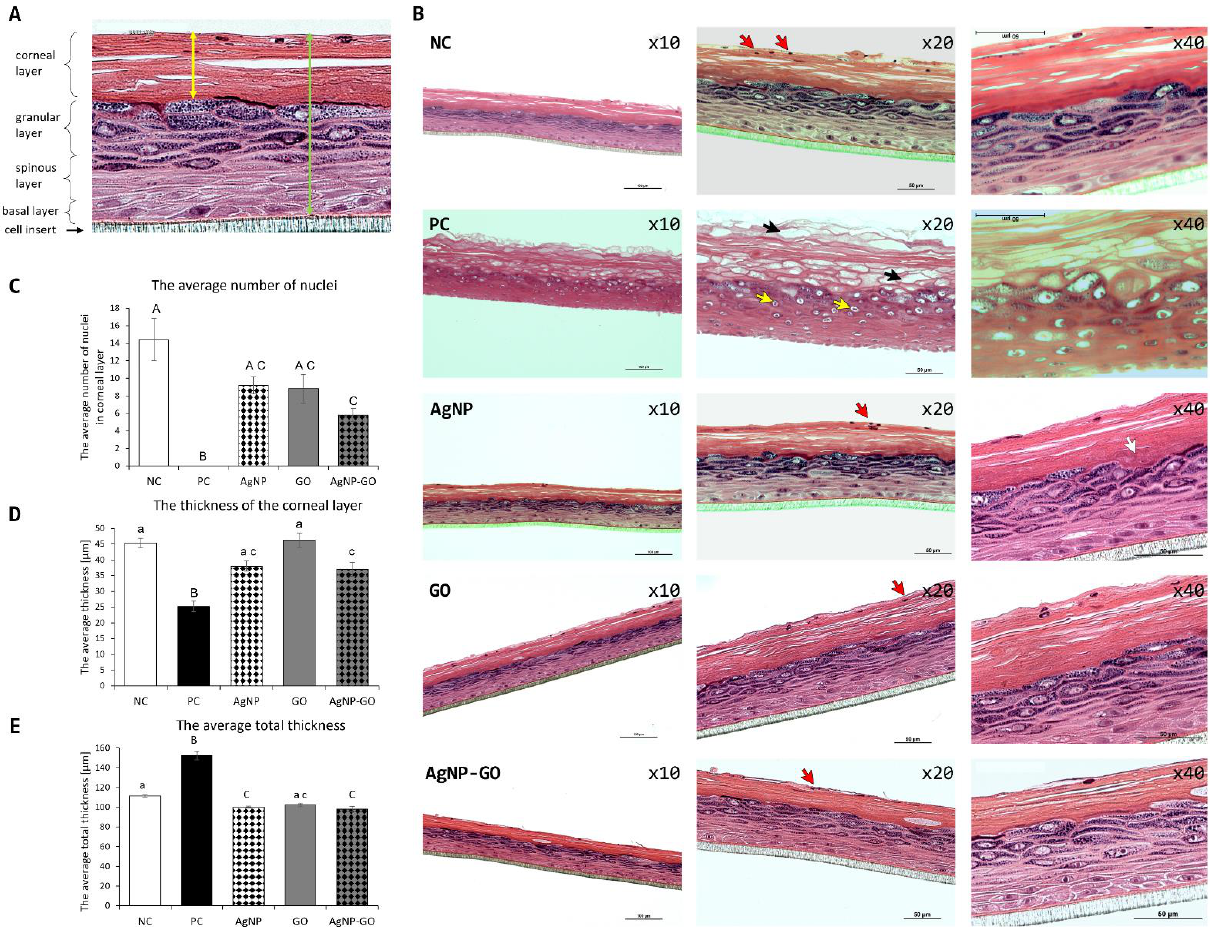
Figure 5. The EpiDerm™ morphology evaluated by optical microscopy after hematoxylin-eosin cross section staining. ( A ) Scheme of the EpiDerm™ structure. The double headed arrows indicate the boundaries of the measurement for the thickness of the corneal layer (yellow) and total thickness (green). ( B ) Visualization of the tissues after treatment at 10×, 20×, and 40× magnifications. Red arrows indicate the nuclei, black arrows indicate tissue damaged after SDS treatment, yellow arrows show the necrosis process, and the white arrow shows a place with local thickening of the stratum corneum. ( C ) The average number of nuclei in stratum corneum. ( D ) The average thickness of stratum corneum. ( E ) The average total thickness. Different letters (a, c) and (A – C) above the columns indicate statistically significant differences ( p ≤ 0.05 and p ≤ 0.01 respectively) as analyzed by Tukey’s HSD test. NC — negative control, PC — positive control, AgNP — silver nanoparticles, GO — graphene oxide, AgNP-GO — complex of silver nanoparticles and graphene oxide.